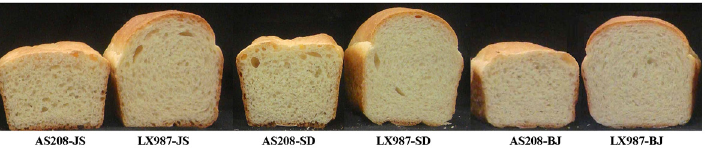
Fig 6. Bread shapes made from AS208 and LX987 flour from plants grown in different experimental locations. The size of bread made with flour of AS208 was much smaller than that of bread made with flour of LX987 produced in the three experimental locations. BJ, SD, and JS stand for the wheat grains harvested in Beijing, Shandong, and Jiangsu, respectively.